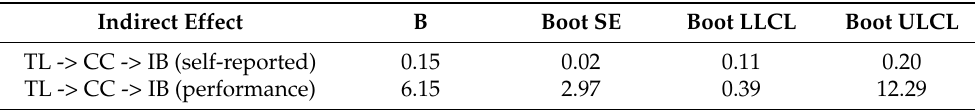
Table 4. Summary of indirect effects in the relationship among TL, CC, and IB.